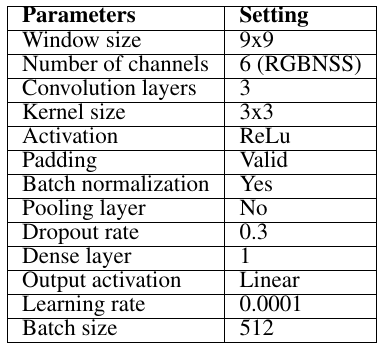
Figure 11. SDB results in Southewest (a, b) and San Juan (c, d). Table 7. Summary of CNN